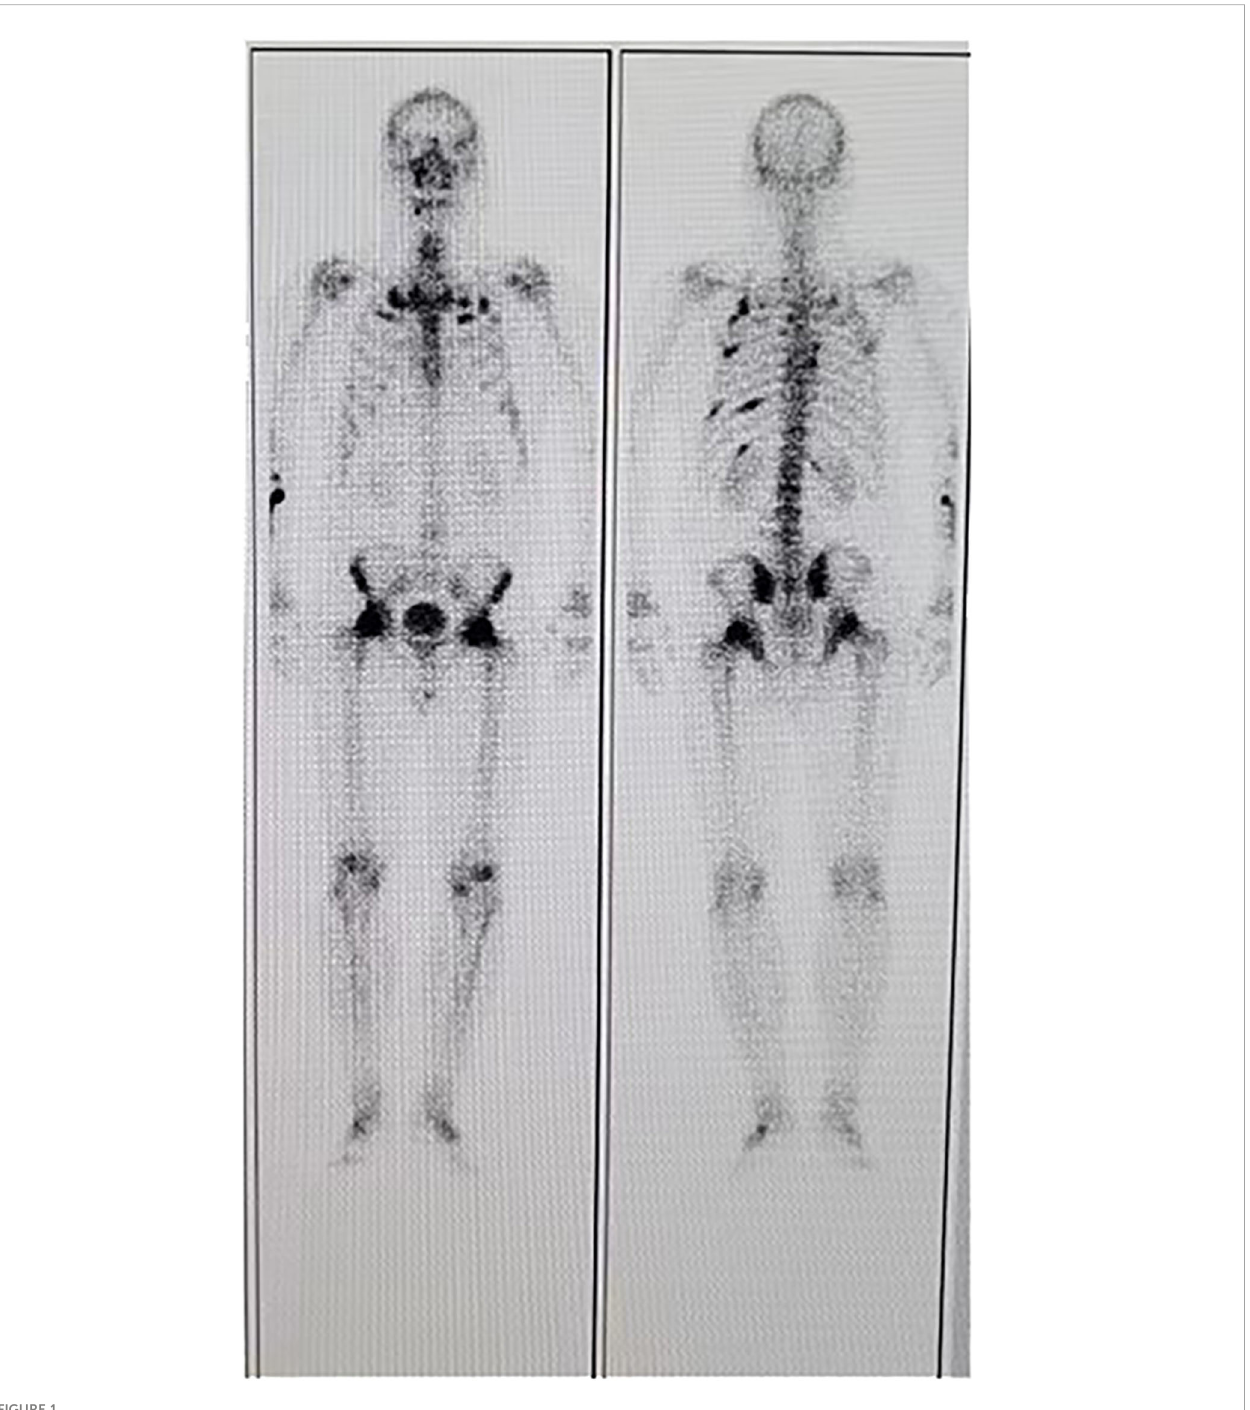
FIGURE 1 Bone scan of the patient showing multiple uptakes similar to